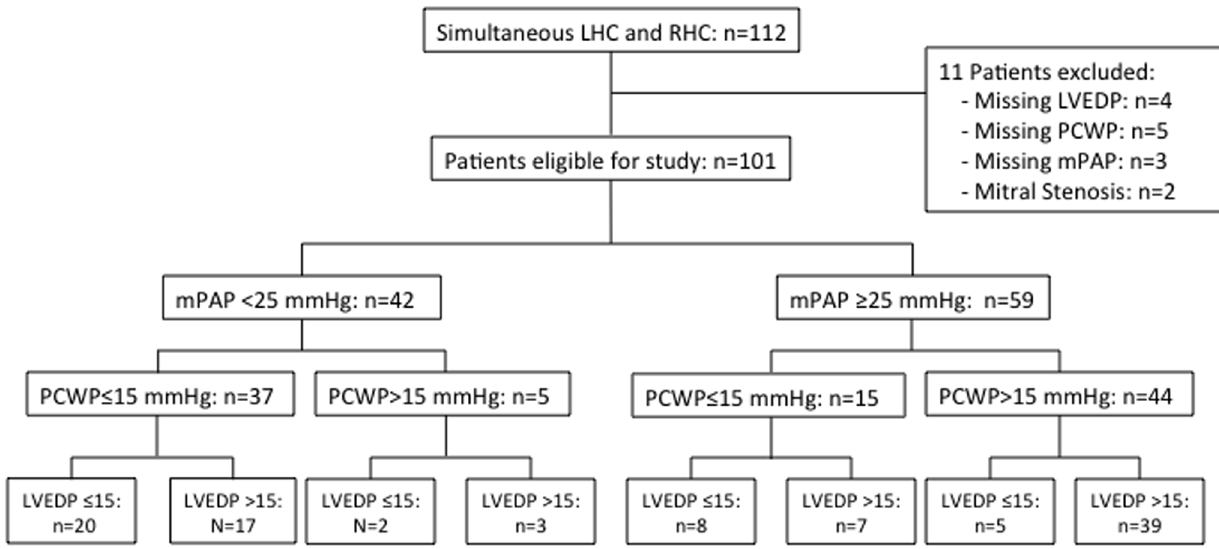
Figure 1. Patient flow chart. LHC, left heart catheterization; LVEDP, left ventricular end-diastolic pressure; mPAP, mean pulmonary artery pressure; PCWP, pulmonary capillary wedge pressure; RHC, right heart catheterization.